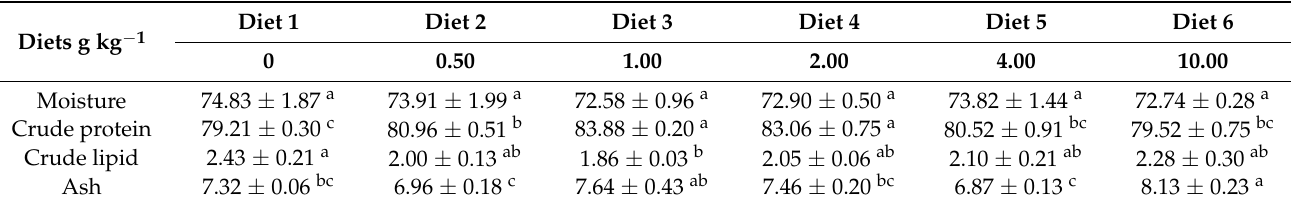
Table 6. Effects of ELE on proximate muscle composition of Cherax quadricarinatus .